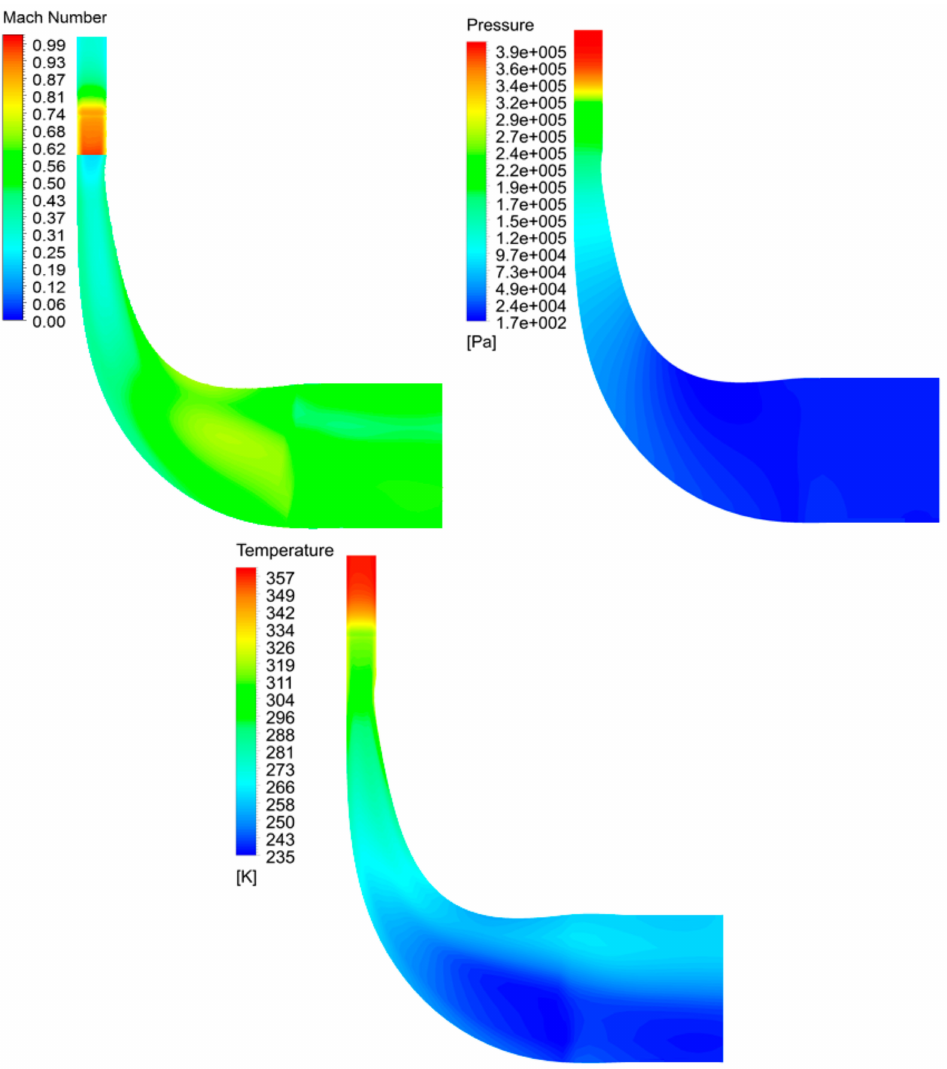
Figure 18. Meridional view of static pressure, static temperature and Mach number at the design